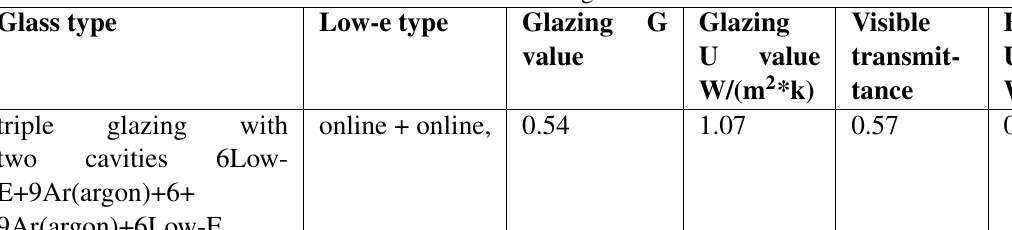
Table 7 Parameter of glass and window.